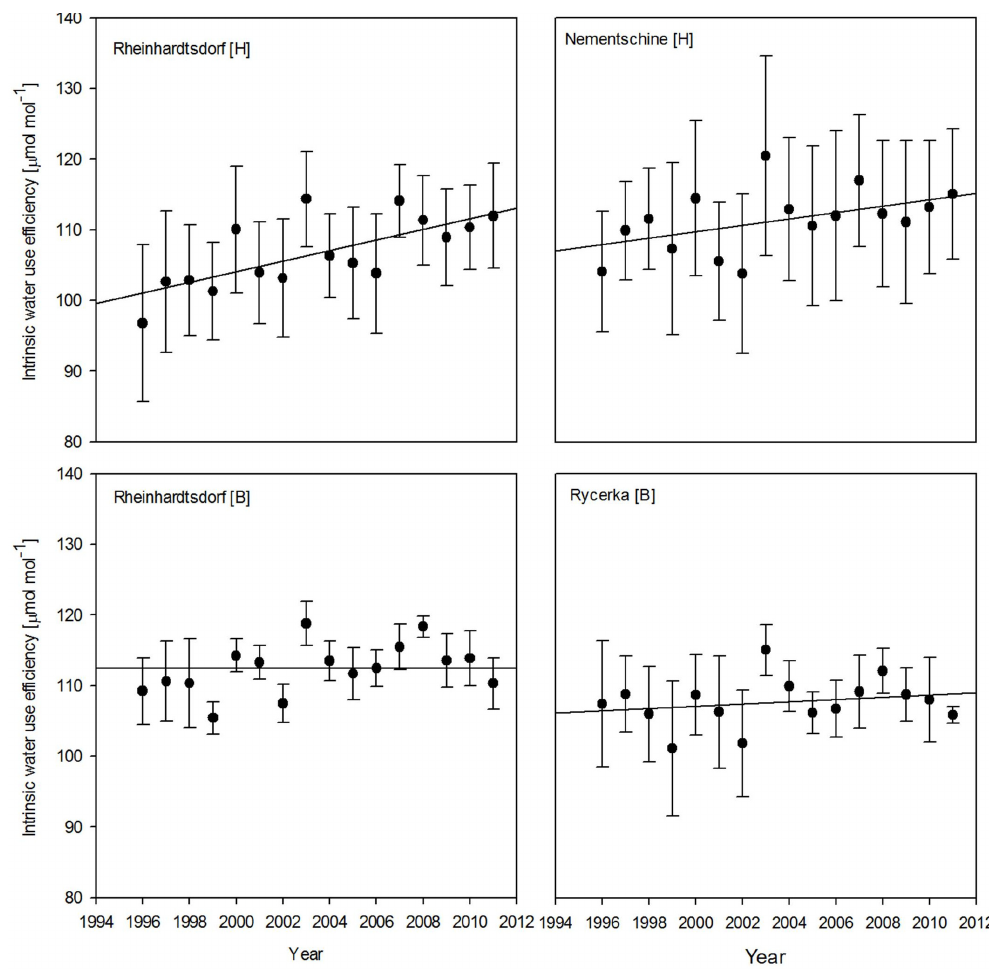
Figure 2. Trends in water use efficiency over the 15 year investigation period for all samples. Error bars indicate the variance between the five individual trees for each population.